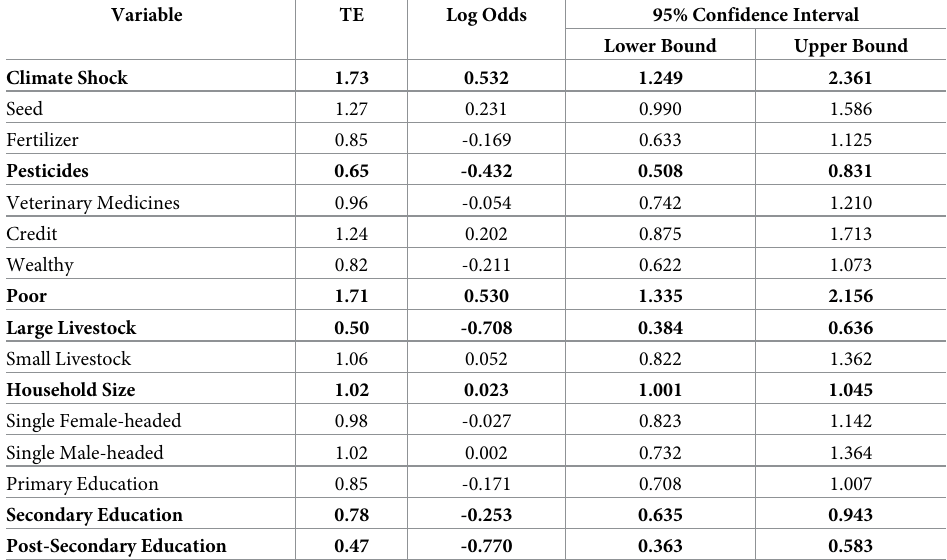
Table 2. Main effects from multi-level hierarchical random effects models. Positive log odds indicate greater odds of food insecurity, while negative log odds indicate greater odds of food security. Results that are statistically significant within a 95% credibility interval are bolded for emphasis.